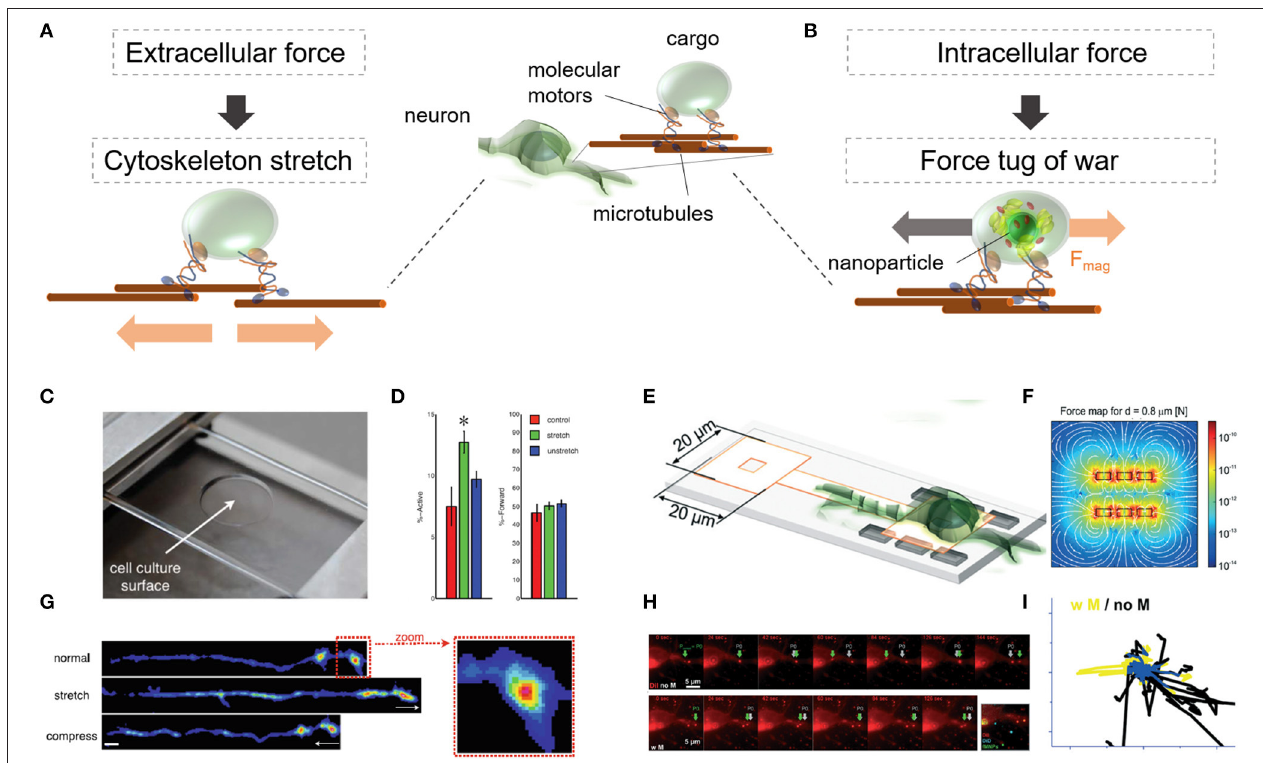
FIGURE 6 | Dynamic behavior of intracellular vesicles is sensitive to force-mediated changes inside and outside of neurons. Changes in vesicle dynamics are studied through (A) a stretchable or (B) a localized nanomagnetic cell culture platform. (C) The stretchable cell culture surface imposes a uniform elongation on adherent parts of the cell body and cytoskeleton. (D) Histogram shows differences in force-mediated active vs. axonal forward (anterograde) transport. (E) On chip method to mechanically interfere with vesicle dynamics inside neurons through nanomagnetic forces. (F) Estimated nanomagnetic force map. (G) Stretch mediates the increase of synaptic vesicles in neuromuscular synapses in Drosophila embryonic motor neurons. (H) Nanoparticle-laden lipid vesicles in primary cortical neurons alter their movement pattern under magnetic forces. (I) Extracted vesicle tracks without (no M) and with (w M) nanomagnetic forces. (C,D,G) Reproduced with permission from Ahmed et al. (2012,2013), Copyright © 2012, Royal Society of Chemistry. (E,F,H,I) were adapted and reproduced with permission from Kunze et al. (2017), Copyright © 2017, Royal Society of